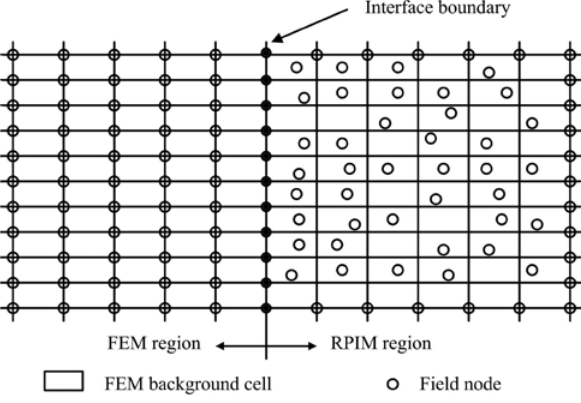
Figure 2 FEM background cells used in coupled RPIM and FEM of the Hamilton canonical